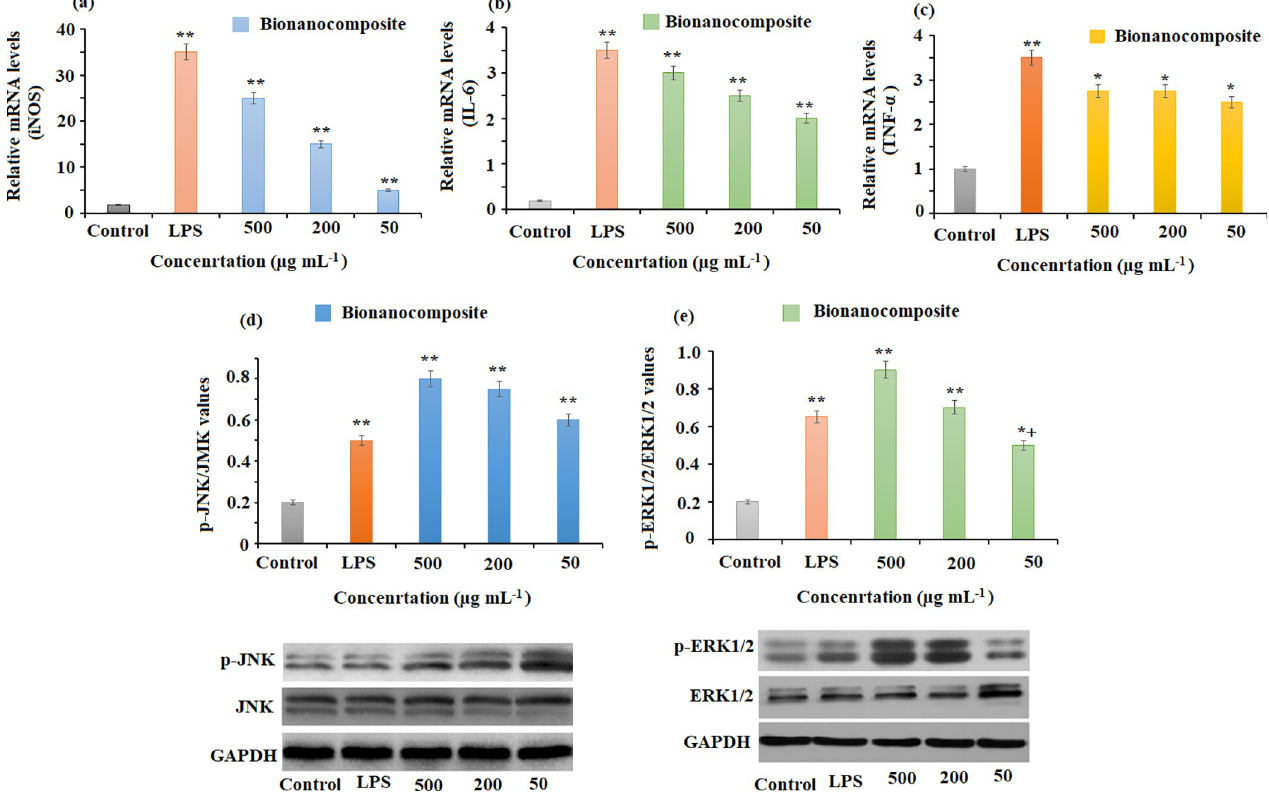
Fig 11. (a–c) the expression (iNOS, IL–6, and TNF– α ) mRNA in RAW264.7 cells treated with sunflower oil/FA–CSNPs bionanocomposite for 12 h. The values were estimated using 2 – ΔΔ CT method (d and e) the protein expression (p–JNK, JNK, p–ERK1/2 and ERK1/2 treated with the bionanocomposite for 6 h. The protein GAPDH was used as loading control. The results are expressed as mean ± standard deviation (n = 3). Significant differences between the treated cells with the control cells were calculated as * ( P < 0 . 05 ) or ** ( P < 0 . 01 ).